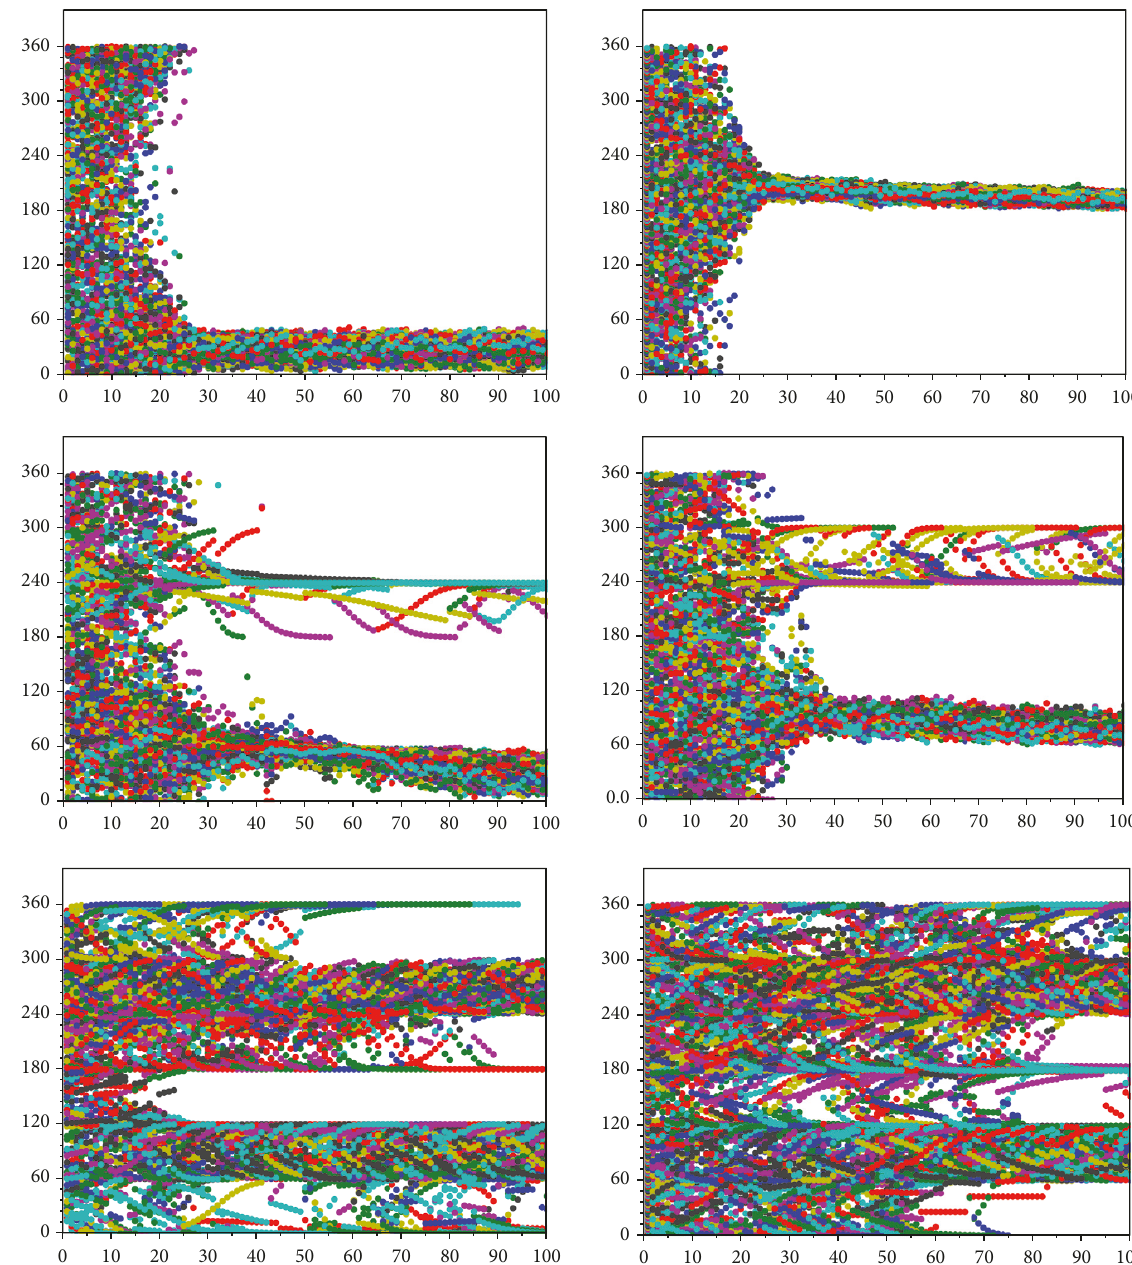
Figure 3: The confidence bounds are 𝜖 = 180 ∘ (top row), 𝜖 = 120 ∘ (middle row), and 𝜖 = 60 (bottom row). 𝜅 𝑖 ∈ [−10 ∘ , 10 ∘ ] . Function 𝑔 1 (𝑥) is used on left column and 𝑔 2 (𝑥) on the right. In the top row, a weak consensus appears throughout the social group. In the middle row, there are two clusters, one grouping most of the opinions and another with a minority of these. In the lower row, the formation, of both weak and strong consensus, can be